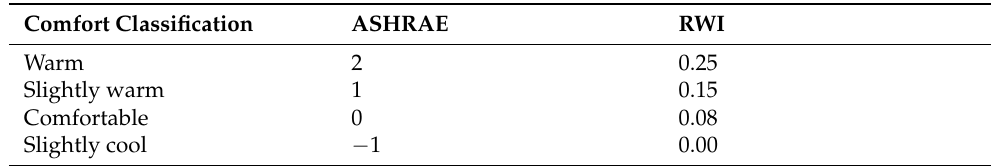
Table 4. American Society of Heating, Refrigerating and Air Conditioning Engineers (ASHRAE) comfort classification using RWI